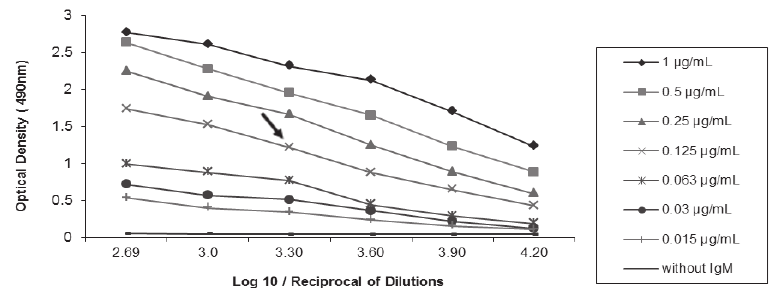
Figure 3 - Titration curves in indirect ELISA of rabbit anti-pacu IgM antiserum that was serially diluted (1:500 to 1:16000) and tested against different coating concentrations (1.0 to 0.015 m g/mL) of purified pacu IgM. The arrow indicates dilution of use for polyclonal antibody (detector 1:2000).